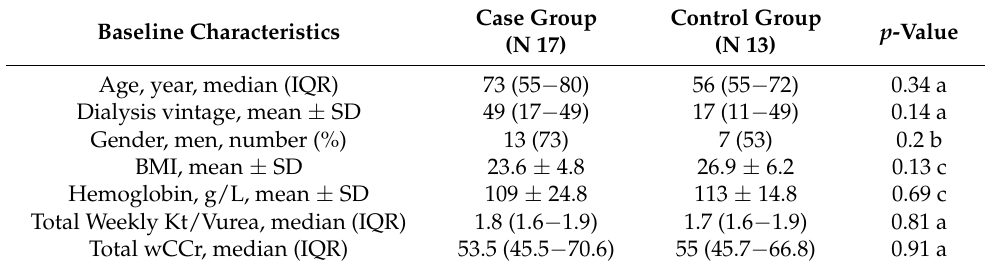
Table 1. Baseline characteristics for case and control group.